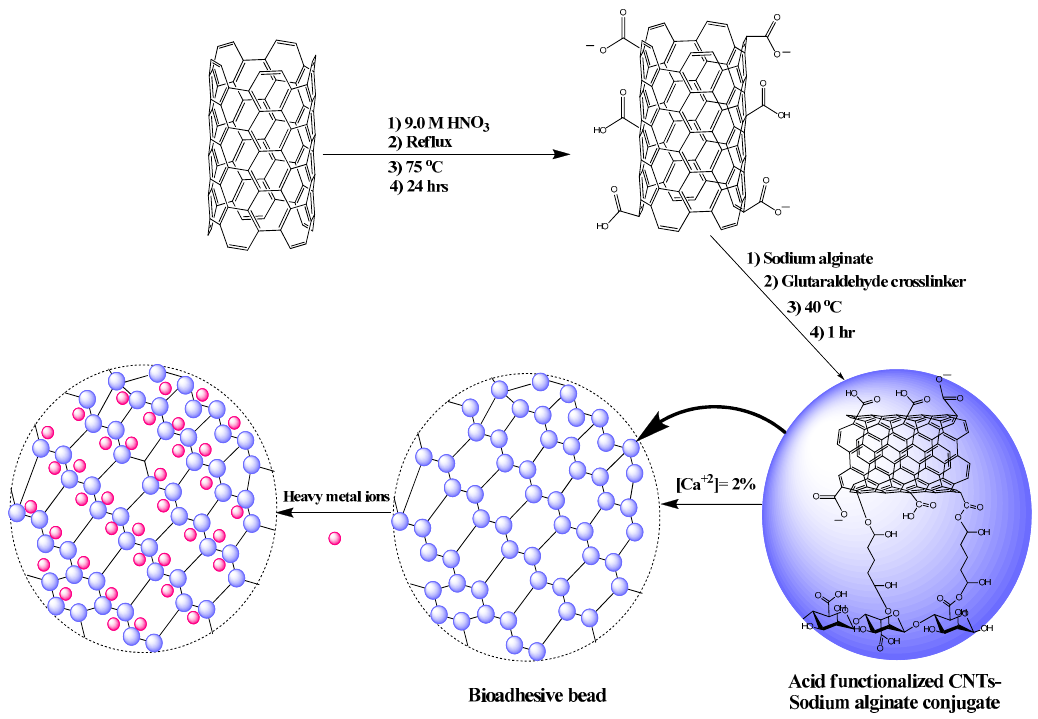
Scheme 1. Schematic illustration of the synthesis process for conjugates and beads.